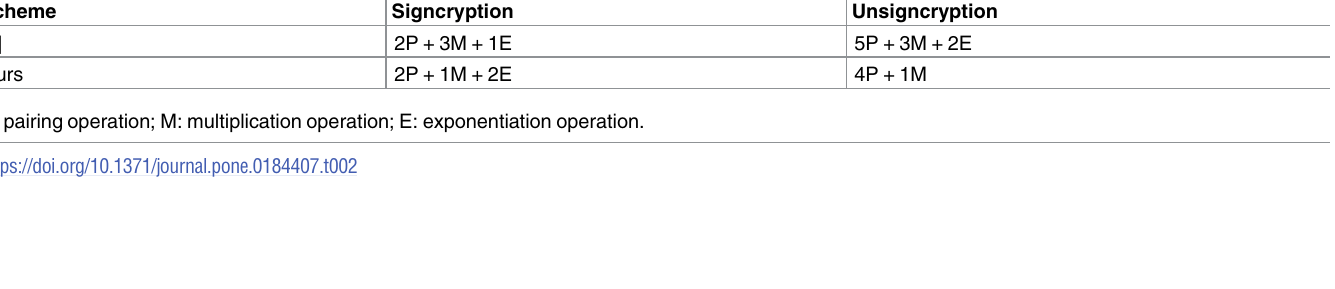
Table 2. Computational cost.